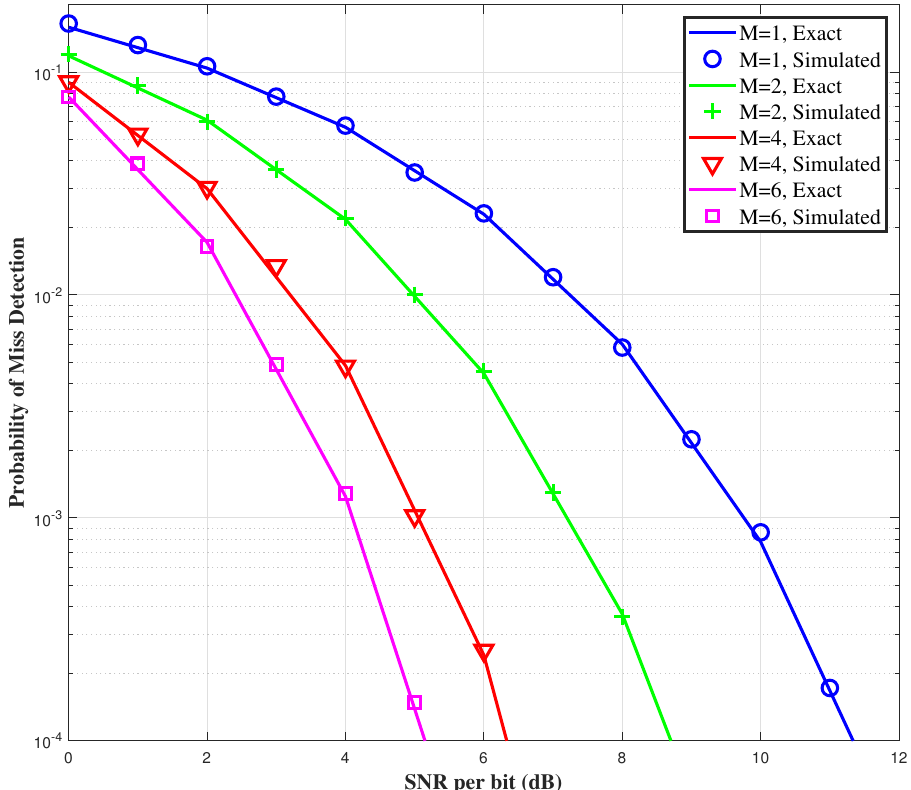
Figure 5. Simulated and calculated Probability of miss detection curve comparison for STH M − ary PPM System. The curves labelled as “Exact” are plotted using (27) where as the markers denote the simulation performance using